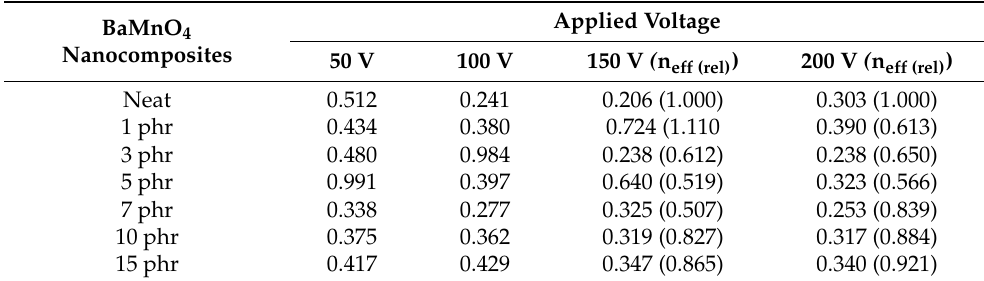
Table 1. Coefficient of energy efficiency (n eff ) and relative coefficient of energy efficiency (n eff (rel) ) of the BaMnO 4 nanocomposites at applied voltages of 50, 100, 150 and 200 V.